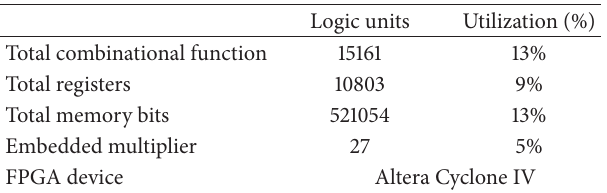
Logic units Utilization (%) 521054